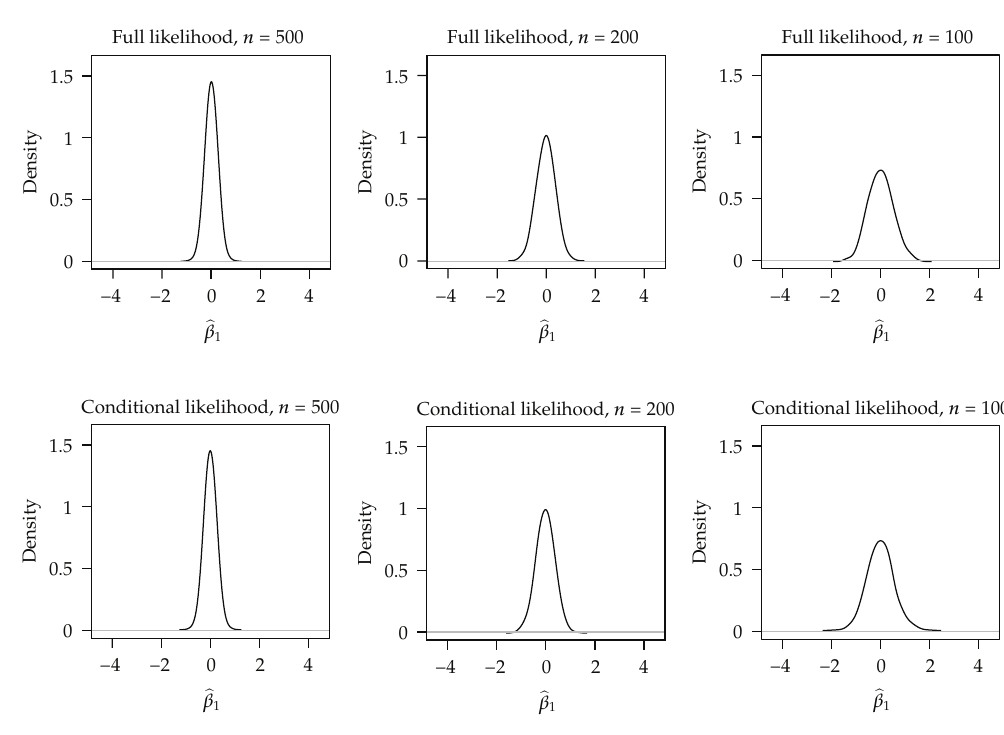
Figure 2: Sampling distributions for maximum likelihood estimates of regression coe ffi cient β 1 from 1000 replications; NPQM model fitted to normal data (cid:5) Y i ∼ N (cid:5) 4 , 4 (cid:6)(cid:6)